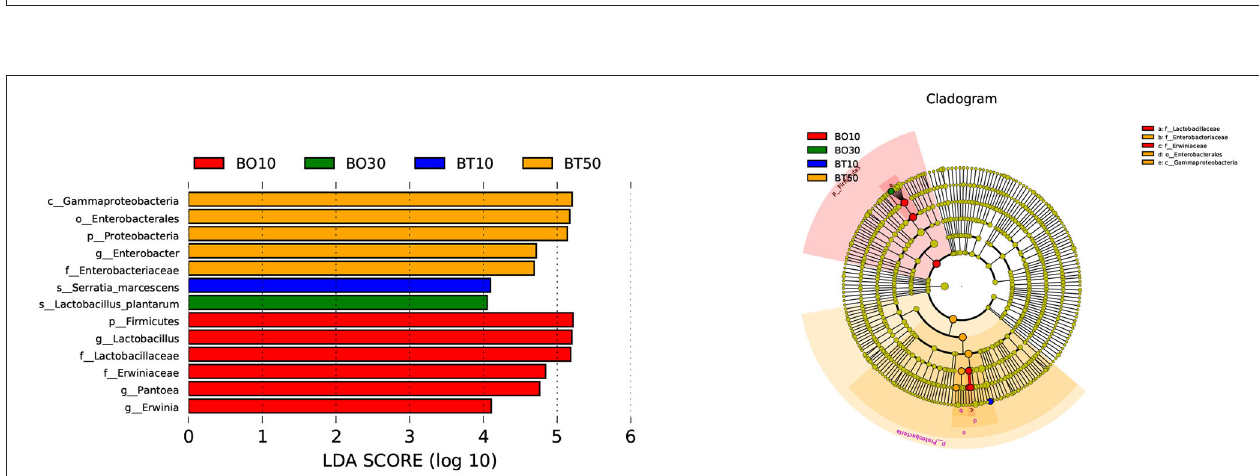
FIGURE 5 | Comparison of bacterial variations in mixed silage using the LEfSe online tool. BO10, 10% faba bean with 90% oat mixed silage; BO30, 30% faba bean with 70% oat mixed silage; BT10, 10% faba bean with 90% forage wheat mixed silage; BT50, 50% faba bean with 50% forage wheat mixed silage.